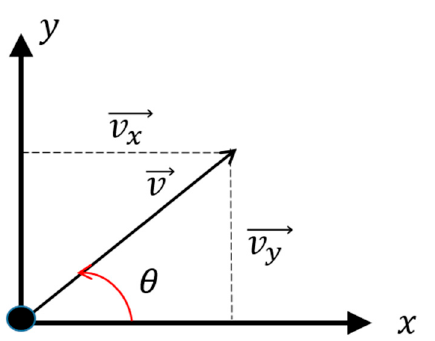
Figure 4. Schematic diagram of the particle velocity and two-dimensional orthogonal components.